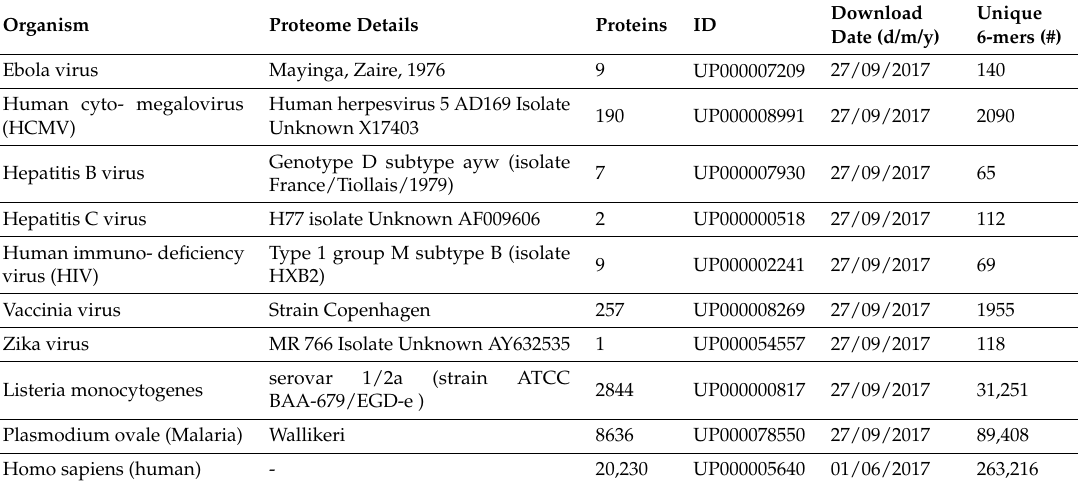
Table A1. List of proteomes used to extract MHC-I binders. See also Methods